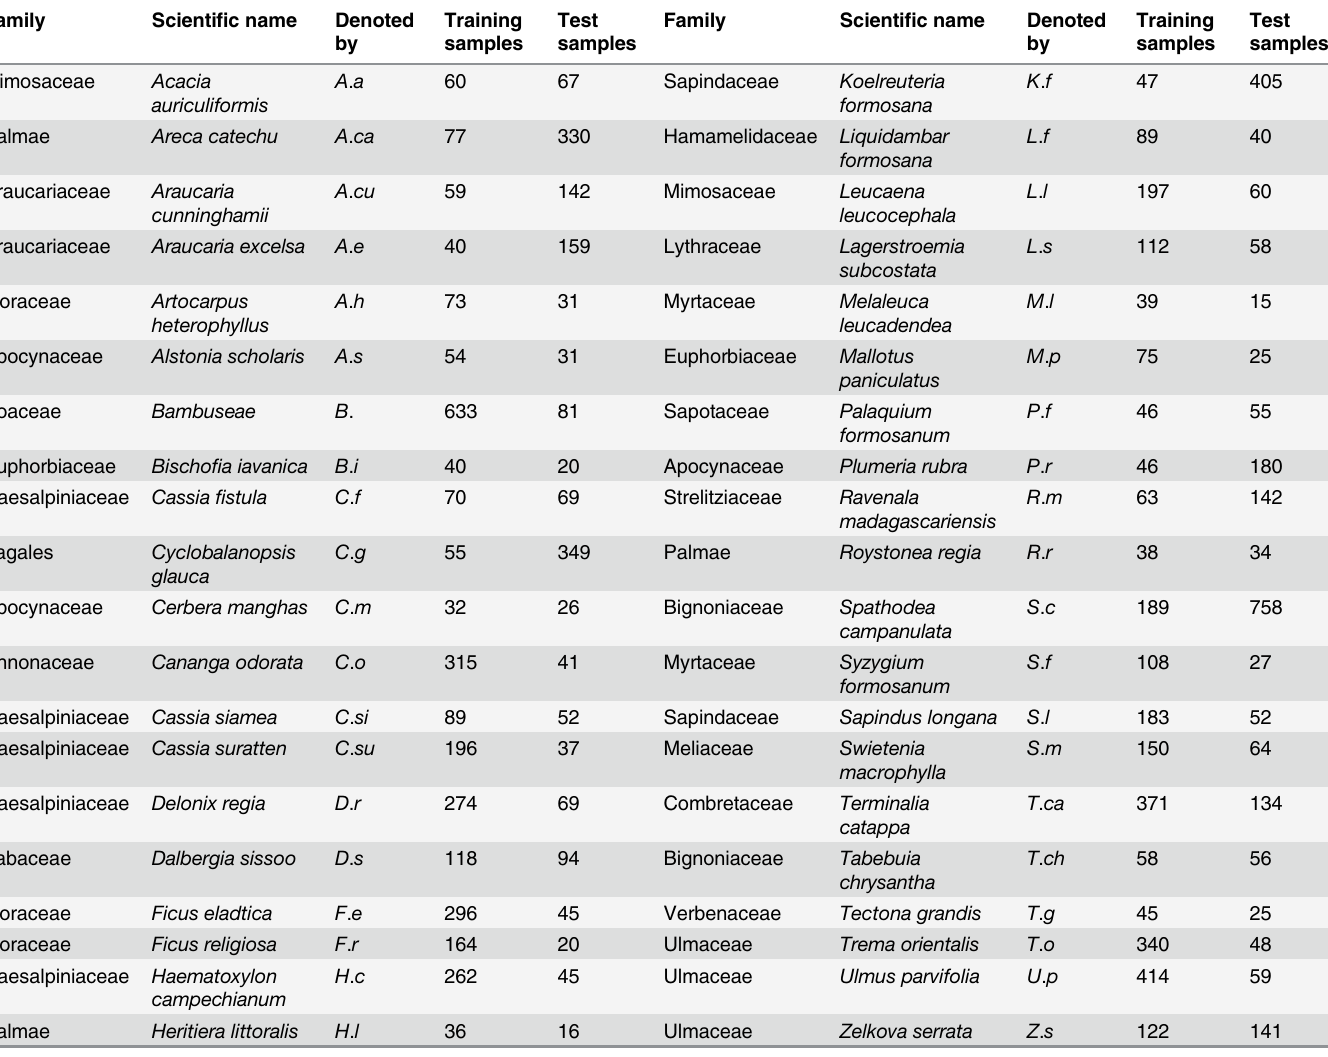
Table 1. Tree species used for spectral-spatial texture